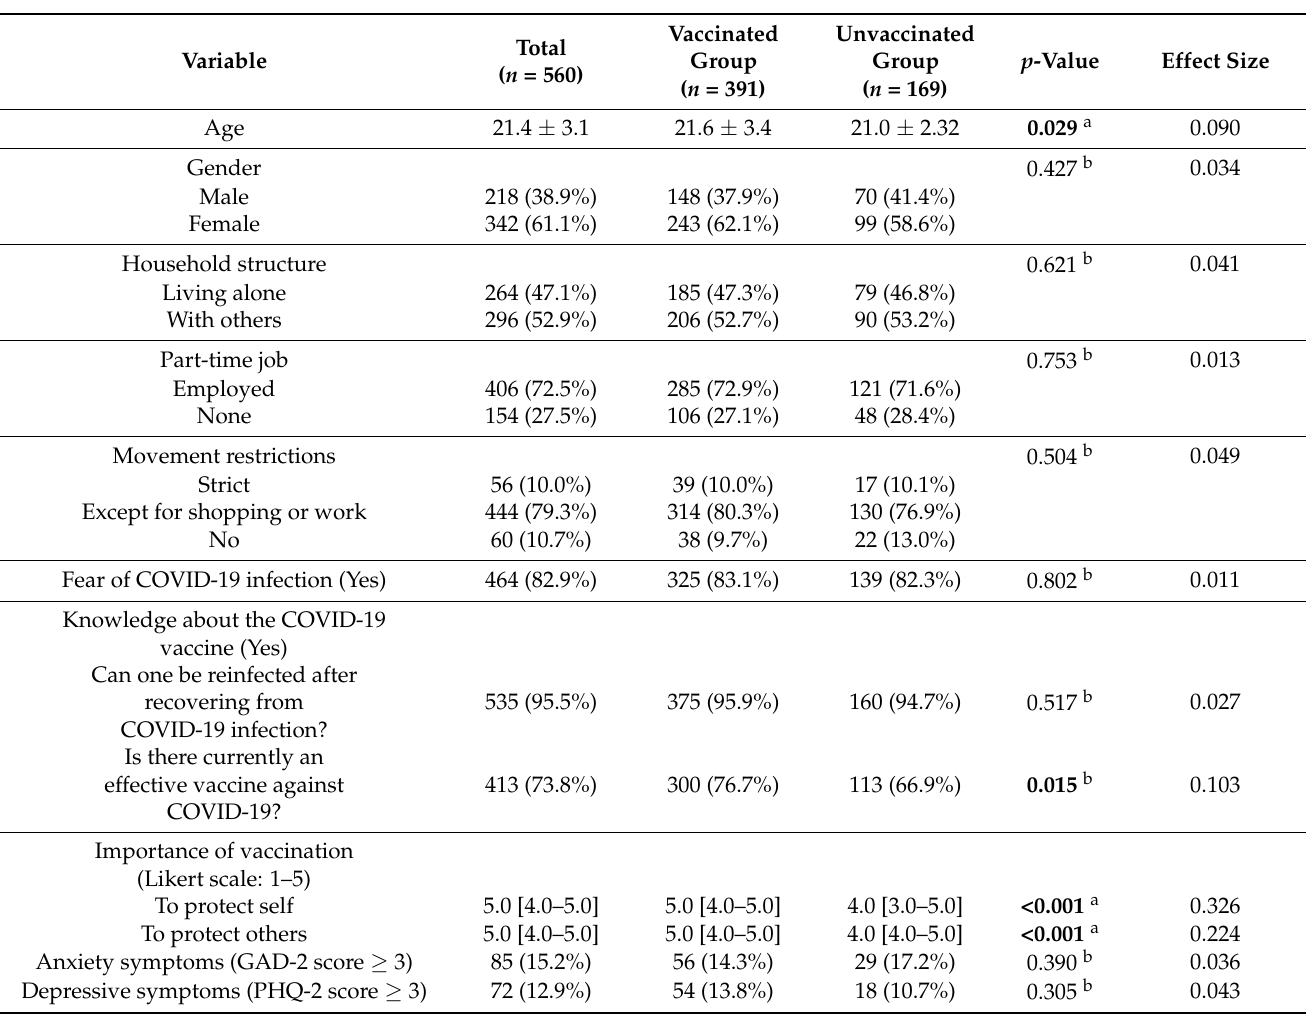
Table 1. Sociodemographic data, mental health status, and knowledge of and attitude toward COVID-19 among participants according to vaccination